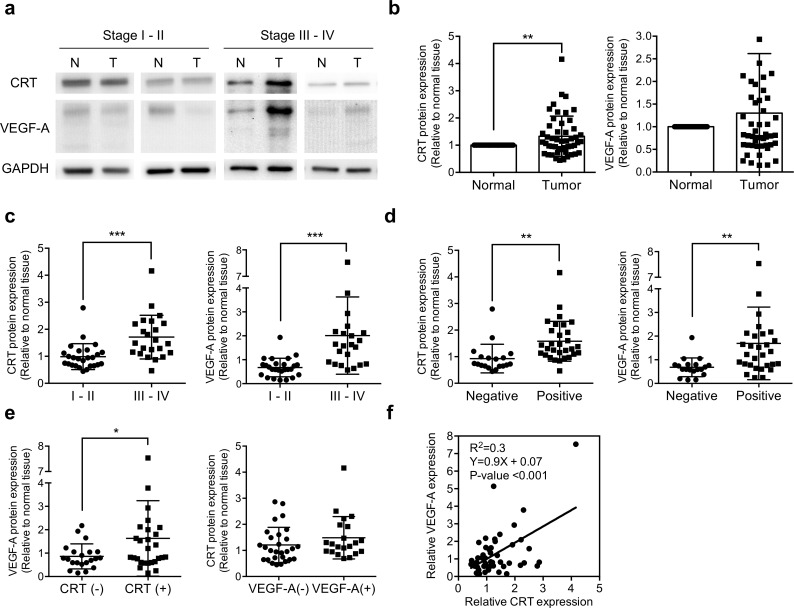
The expression levels of CRT and VEGF-A protein in gastric cancer tissues.Western blot analysis of CRT and VEGF-A from 49 pairs of gastric cancer and matched non-tumor tissues. The expression levels of CRT (63 kD) and VEGF-A (isoform from 27 to 45 kD) were normalized with GAPDH and compared to matched non-tumor tissues. (a) Western blot analysis of CRT and VEGF-A from control-tumor pairs of stage I-II and III-IV gastric cancer tissues in different cropped membranes. (b) CRT protein expression was significantly higher in the gastric cancer tissues than in adjacent non-tumor tissues, whereas no significant change in VEGF-A was observed in the 49 paired gastric cancer tissues. (c) Tumor samples were divided into two groups according to stage for analysis (26 paired stage I-II and 23 paired stage III-IV). Both CRT and VEGF-A protein expressions were higher in the patients with an advanced stage III-IV than in stage I-II. (d) Patients were further grouping by nodal status. Both CRT and VEGF-A expressions were higher in 30 paired gastric cancer tissues with positive node metastasis than in 19 node-negative patients. (e) Samples were grouped according to CRT (left panel) or VEGF-A (right panel) protein expression, including 21 pairs of a low CRT expression, 28 pairs of a high CRT expression, 28 pairs of a low VEGF-A expression, and 21 pairs of a high VEGF-A expression. VEGF-A protein expression was higher in the CRT overexpressed group, whereas CRT was not altered in the VEGF-A overexpressed group. (f) CRT and VEGF-A were positively correlated with gastric cancer. P-values were determined using the t-test (*P ≤ 0.05, **P ≤ 0.01, ***P ≤ 0.001). Error bars represent SD.